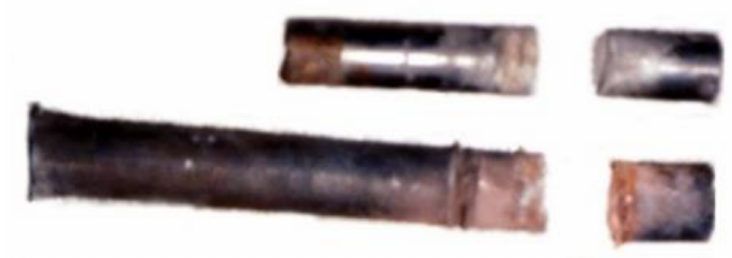
Figure 7. Fractured rods